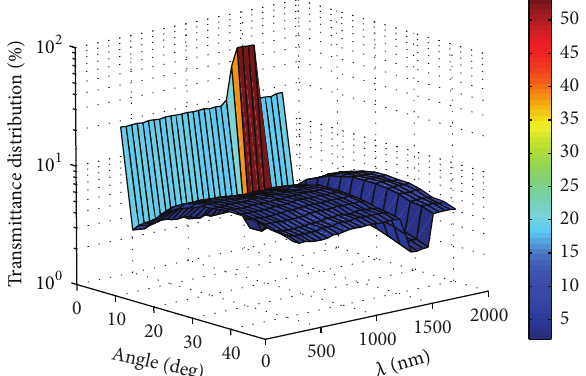
Figure 10: Spectral angular transmittance distribution of the ther- motropic material at 36 ∘